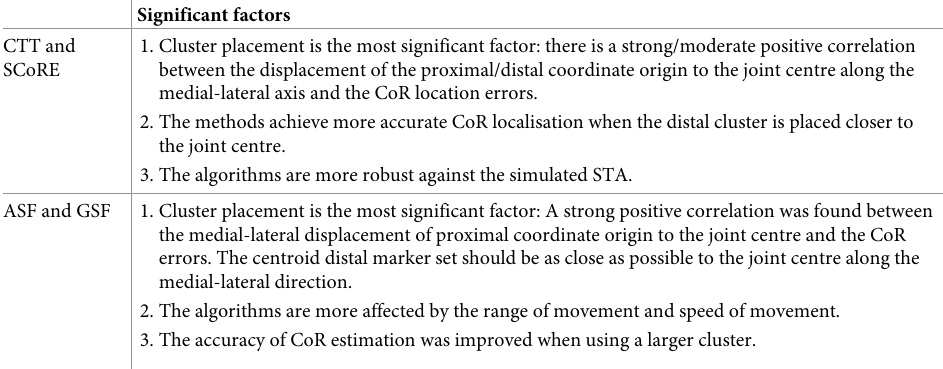
Table 3. Summary of significant factors for functional methods on CoR